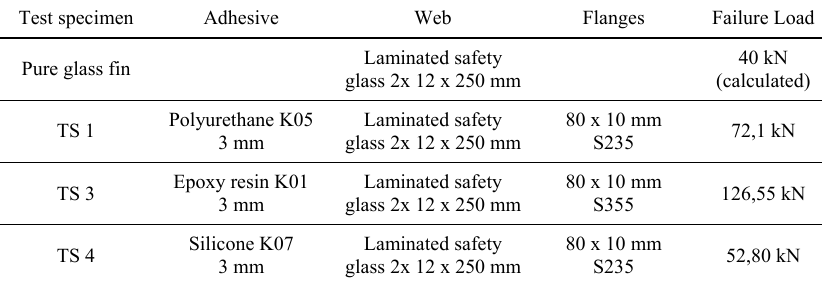
Table 3: Test matrix of full scale tests.